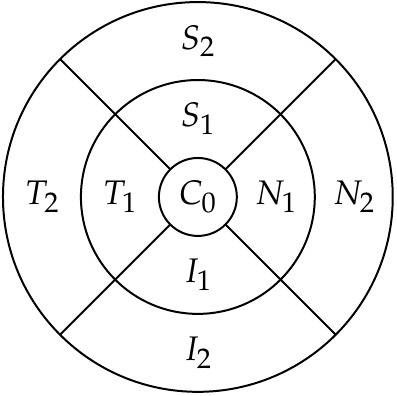
Figure 2. The 9 zones analysed in the retina ( C 0 is the